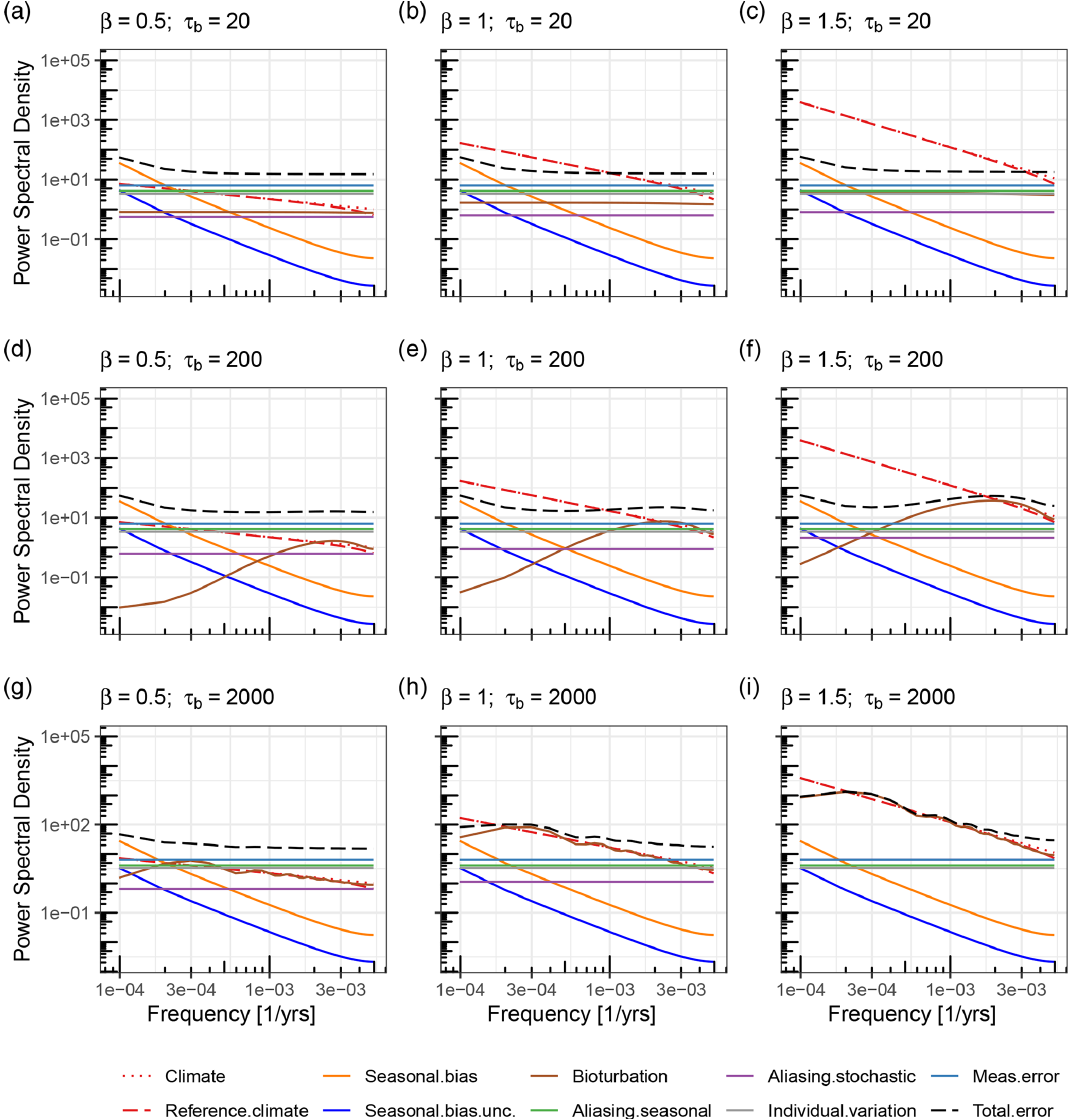
Figure A2. A comparison of error spectra using different slopes for the power-law portion of the stochastic climate spectrum. Comparisons are made for slopes, β , of 0.5, 1, and 1.5 and for different amounts of bioturbation smoothing with values for τ b of 20, 200, and 2000